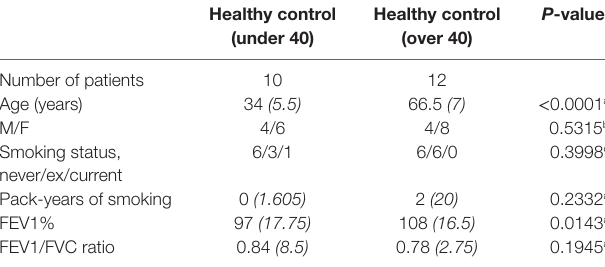
TaBle 2 | Cohort demographics for age comparison study.